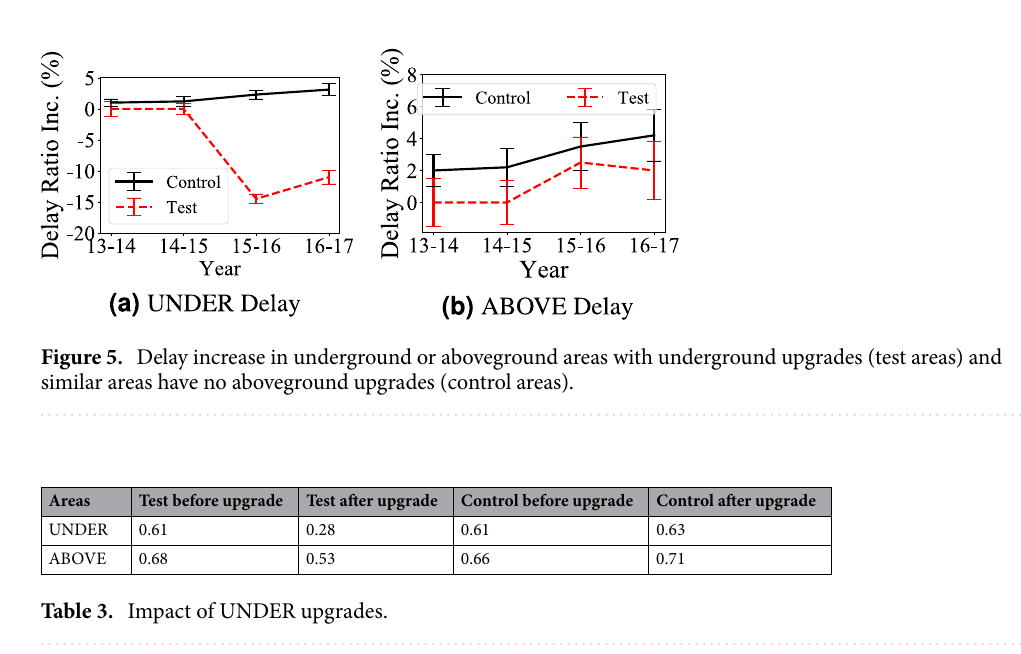
Figure 4. Impact of new highway; ( a ) new highway increases underground delay in test areas after open (TA- A); ( b ) new highway decreases aboveground delay in test areas after open.